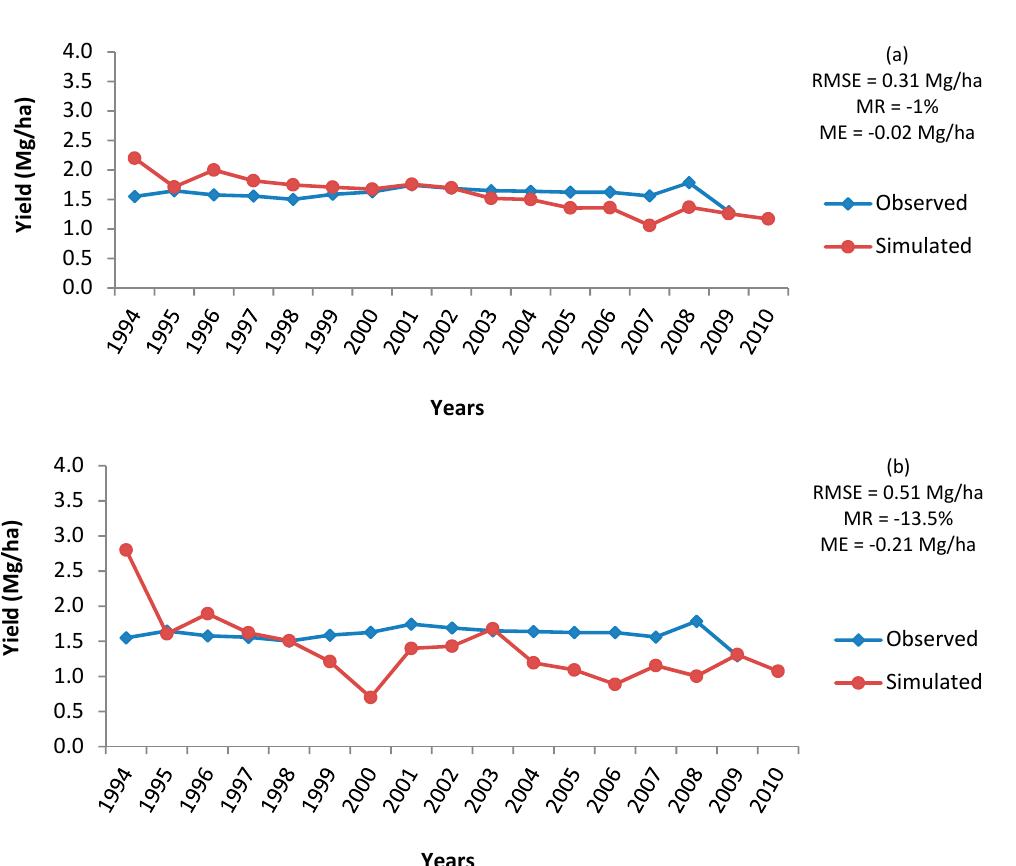
Figure 6. Comparison of observed and simulated maize yield in Nigeria for 17 years (1994–2010) using weather data under Approach 1(where data was obtained from a single source) ( a ), and Approach 2 (where data was obtained from different sources) ( b ).